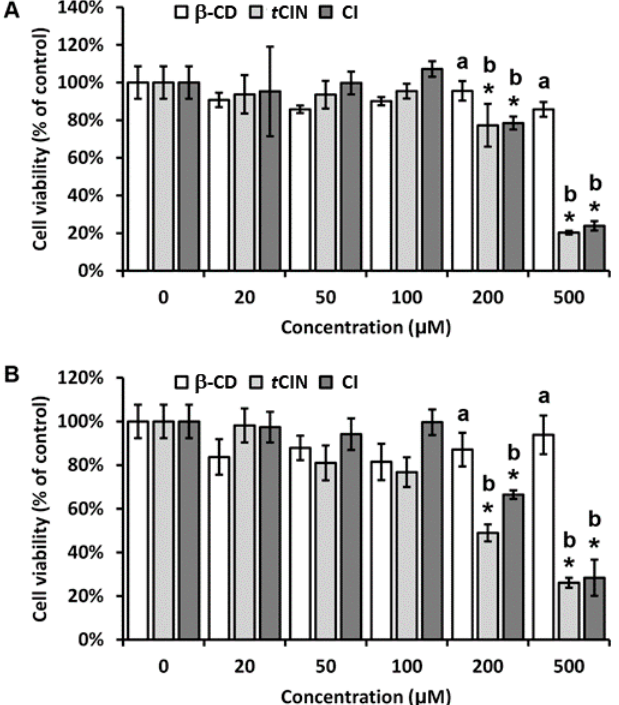
Figure 4. Cell viability. RAW 264.7 macrophages were seeded in 96-well plates for 24 h, followed by 18 h of starvation. Cells were treated with increasing concentrations of β -CD, t CIN, and CIs for 24 h. Cell viability was measured using the MTT assay, and quantified as a percentage (%) of the control. MTT assays were performed at ( A ) week 0 and ( B ) after 3 weeks of storage at 4 °C to evaluate the stability of CI and the effects of storage on CI. The CI was obtained by molecular inclusion at a 1:1 molar ratio of t CIN and β -CD. Data are the mean ± standard deviation (SD). * p < 0.05 versus the control. The different letters indicate p < 0.05 at the same treatment concentration. β -CD, β -cyclodextrin; t CIN, trans -cinnamaldehyde; CI, t CIN and β -CD inclusion complexes; MTT, 3-(4,5-dimethylthiazol-2-yl)-2,5-diphenyltetrazolium bromide.